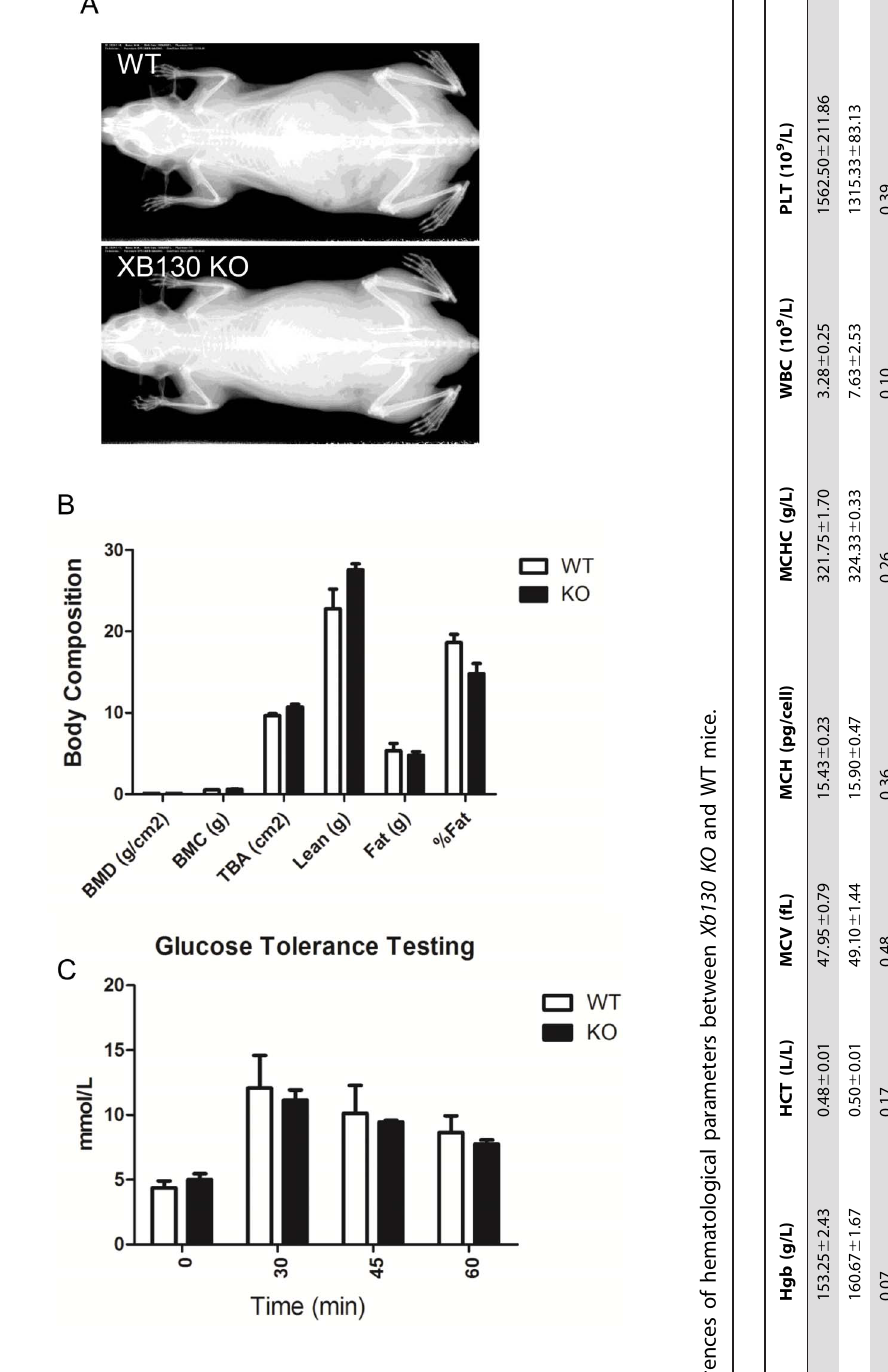
Figure 2. X-ray, body composition analysis and glucose tolerance testing for WT and KO mice. In adult mice, no significant differences were found between WT and KO mice on X-ray (A), body composition (B) and ECG (C). doi:10.1371/journal.pone.0108952.g002 tation model, 4–8 tracheas were evaluated for each group at a particular time point. Body composition evaluation. The body composition of mice was determined using a PIXI-mus Small Animal Densitom- eter (LUNAR, Madison, WI). Mice were anesthetized with 2% isoflurane. X-ray images and analyses included the tail but